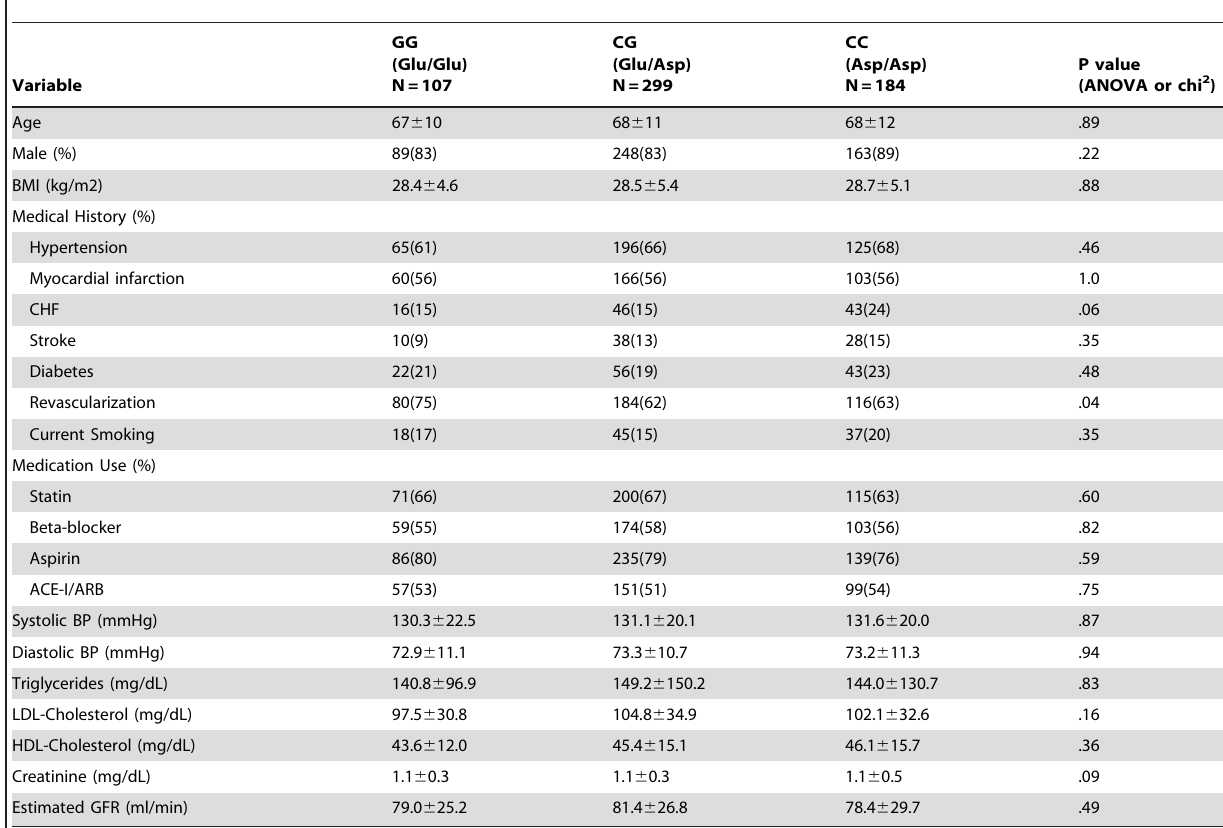
Table 1. Baseline characteristics of participants by genotype at rs2296545.